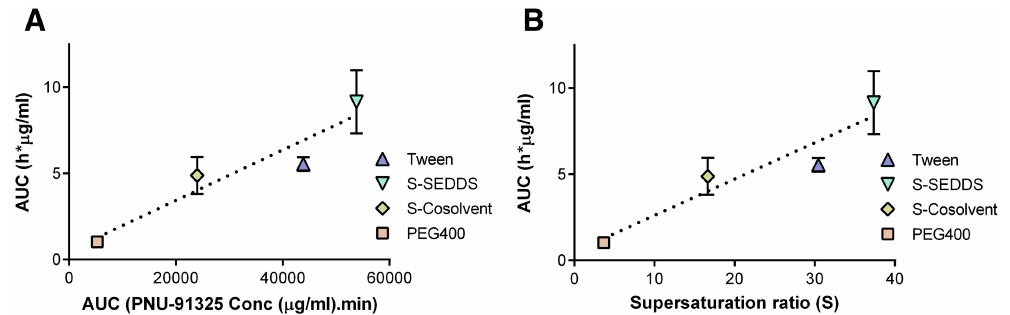
Figure 6. IVIVC of in vivo exposure ( y axis) of PNU-91325 with ( A ) AUC of in vitro drug concentration.min (R 2 = 0.90) and ( B ) in vitro supersaturation ratio (S) during in vitro precipitation tests (R 2 = 0.90). Supersaturation ratio (S) calculated using the method proposed by Anby [52]. Data recalculated and plotted from [121]. Reprinted from [18] with permission (Elsevier 2016).